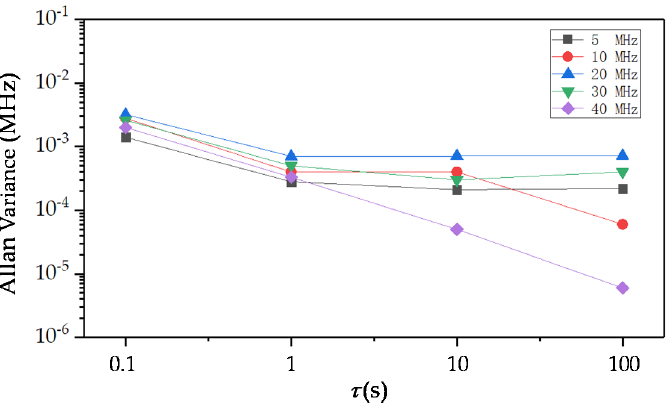
Figure 6. Allan variances at different τ values.